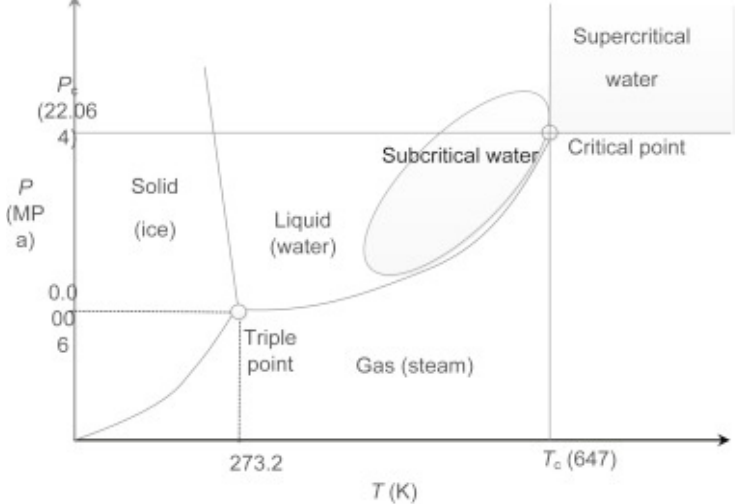
Figure 3. Phase diagram of water with marked sub- and supercritical region, where Pc represents critical pressure and T C critical temperature. Reprinted with permission from ref. [49]. Copyright 2016 Elsevier.